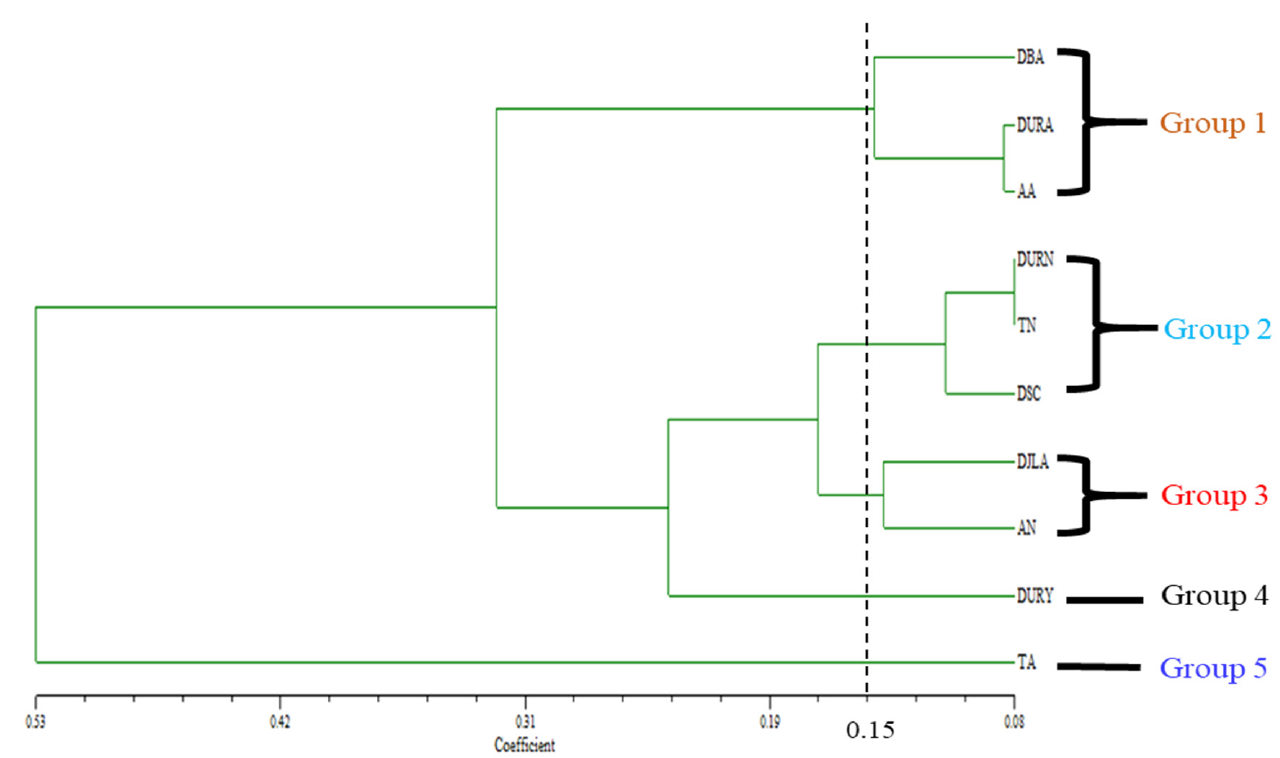
Figure 5. Dendrogram showing relationship amid dura and pisifera genetic origins based on their quantitative characters: A, AVROS; DBA, Deli Banting × AVROS; DURN, Deli Ulu Remis × Nigeria; DJLA, Deli Johor Labis × AVROS; DURA, Deli Ulu Remis × AVROS; AA, Angola × AVROS; TN, Tanzania × Nigeria; DURY, Deli Ulu Remis × Yagambi; AN, Angola × Nigeria; TA, Tanzania × AVROS; DSC, Deli Serdang ×